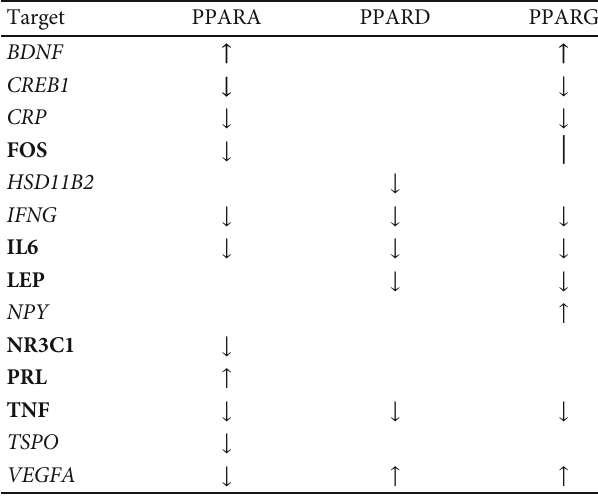
Table 2: Anxiety-associated proteins and PPARs — directions of